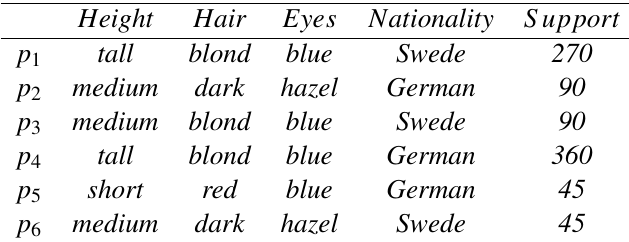
Table 1. Characterization of Population